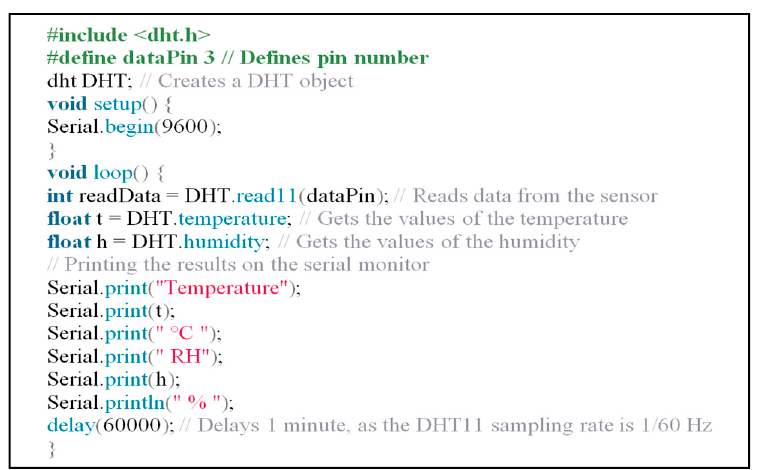
Figure 13. The main code used for the Arduino Uno microcontroller to monitor the temperature and relative humidity inside the flight chamber.